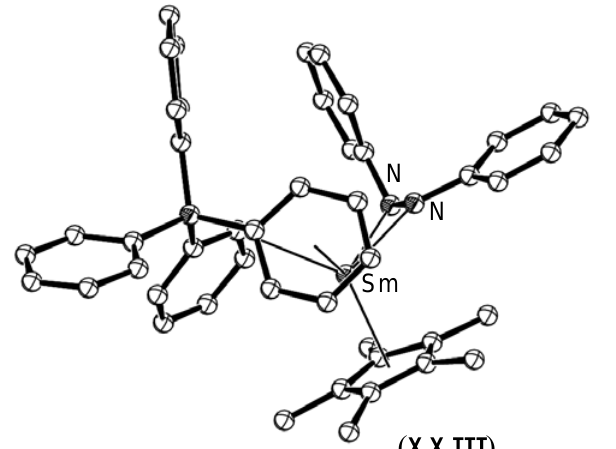
Figure 10. Molecular structure of [(C Figure generated from CCDC obtained coordinates. Atoms of arbitrary size. H atoms are omitted for